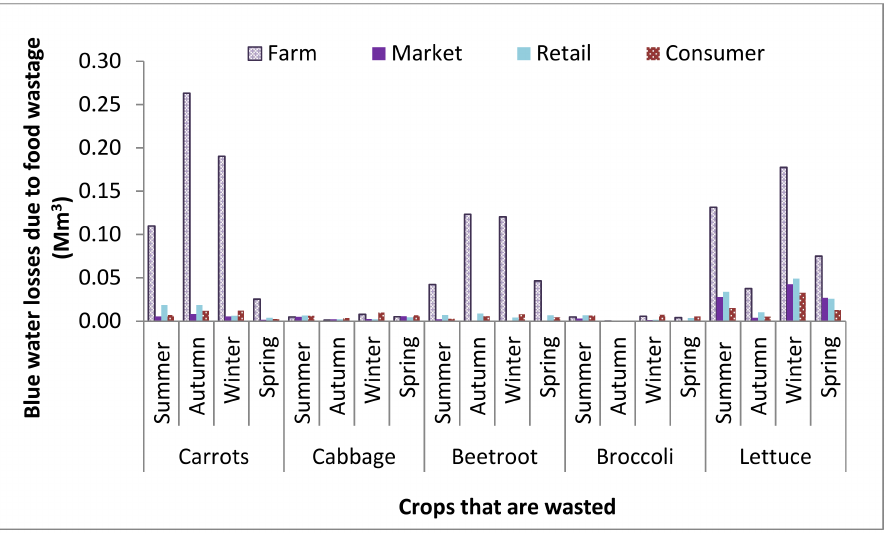
Figure 6. Blue water losses through food wastage along the supply chain from the field to the consumer due to vegetables produced on the Steenkoppies Aquifer in